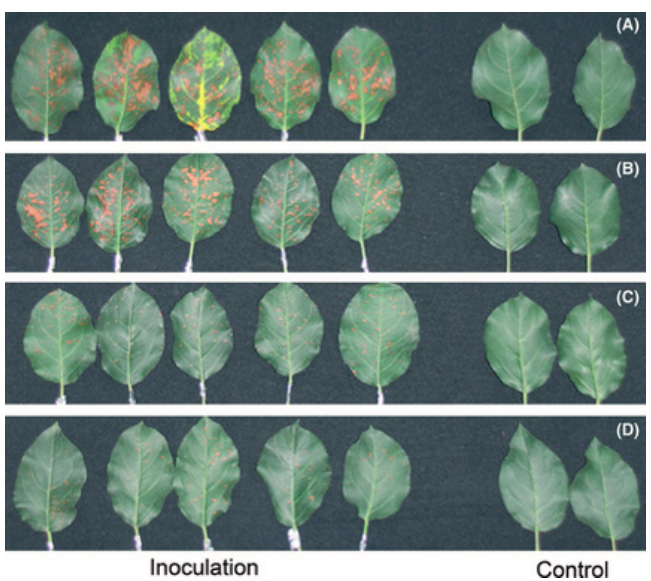
Figure 6. Apple leaf phenotypes at 20 days after being brushed with Marssonina spores; this fungus causes apple blotch disease. Control leaves from trees not brushed with Marssonina spores. Marssonina inoculated leaves from trees that were irrigated with ( A ) no melatonin; ( B ) 0.05 mM; ( C ) 0.1 mM or ( D ) 0.5 mM melatonin solution. From Yin et al. [149] with